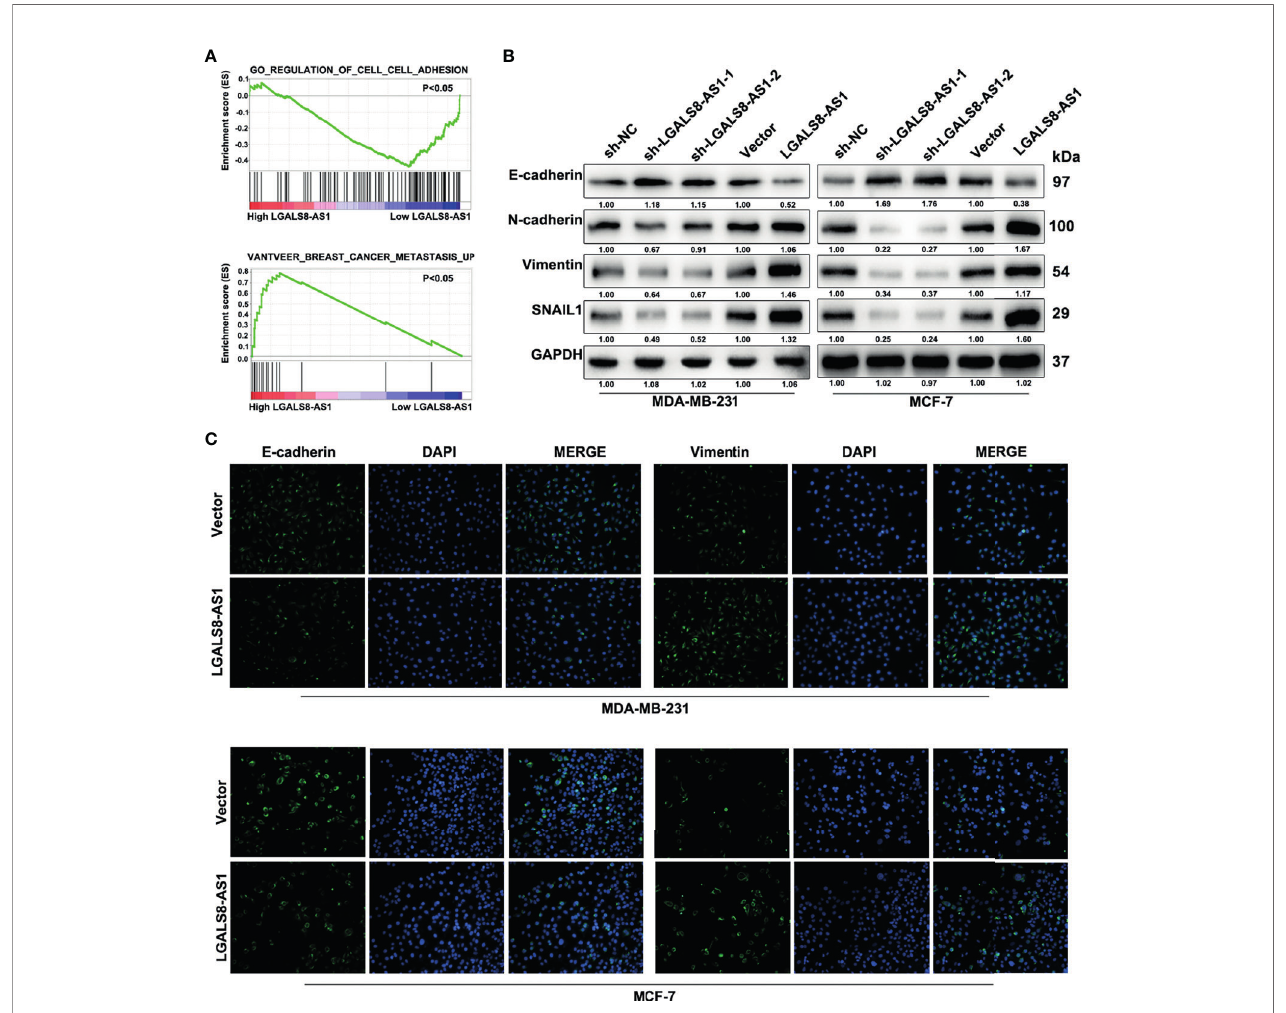
FIGURE 3 | LGALS8-AS1 promotes the metastasis of breast cancer cells via epithelial – mesenchymal transition (EMT). (A) Gene set enrichment analysis (GSEA) revealed that LGALS8-AS1 was related to cell adhesion and metastasis in breast cancer. (B, C) Effect of LGALS8-AS1 knockdown or overexpression on the expressions of EMT-related proteins detected in MDA-MB-231 and MCF-7 cells using Western blot and immuno fl uorescence